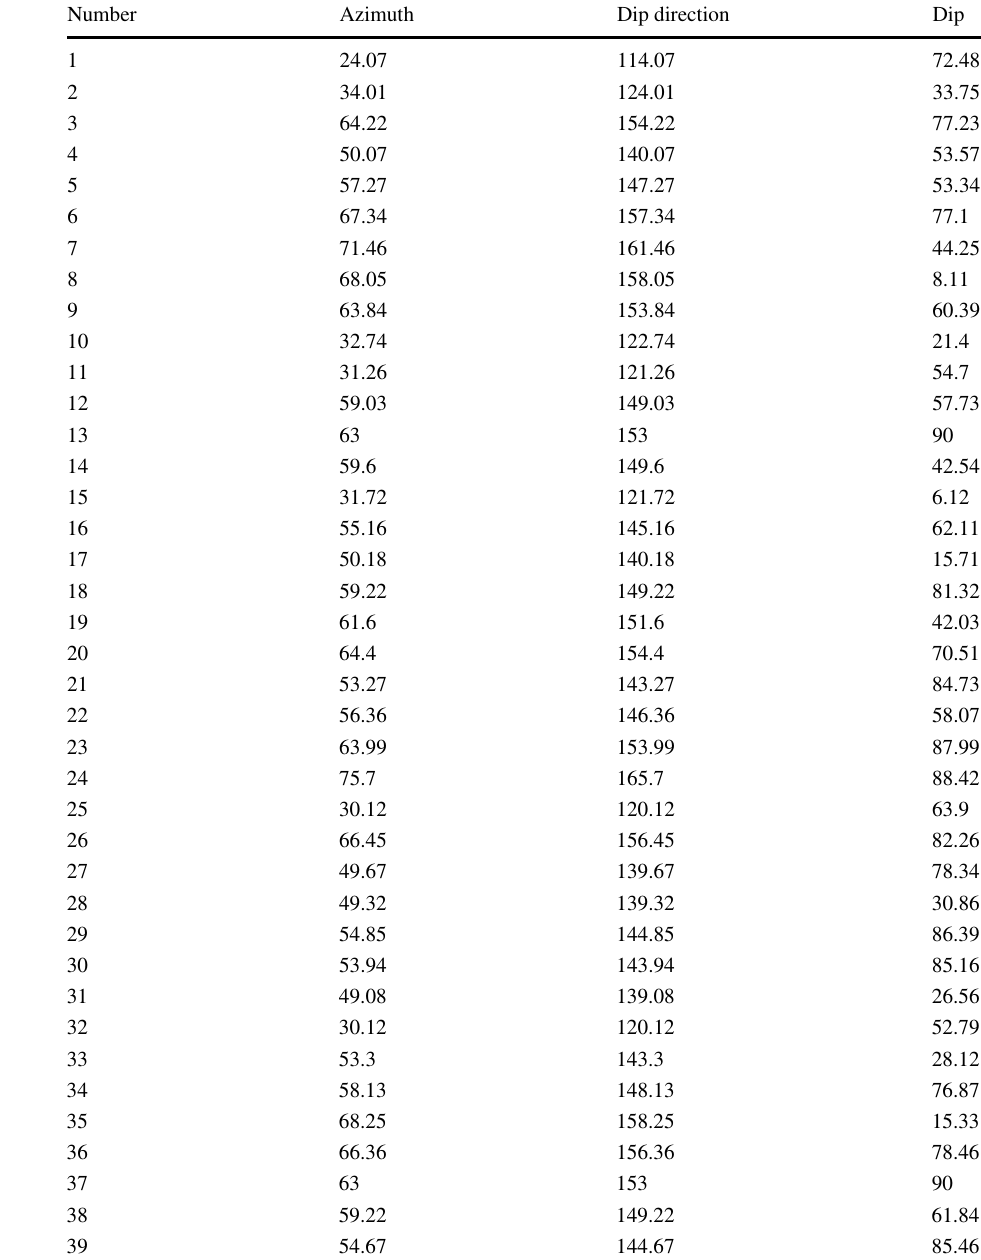
Table 1 Parameters of some fractures of Maxi